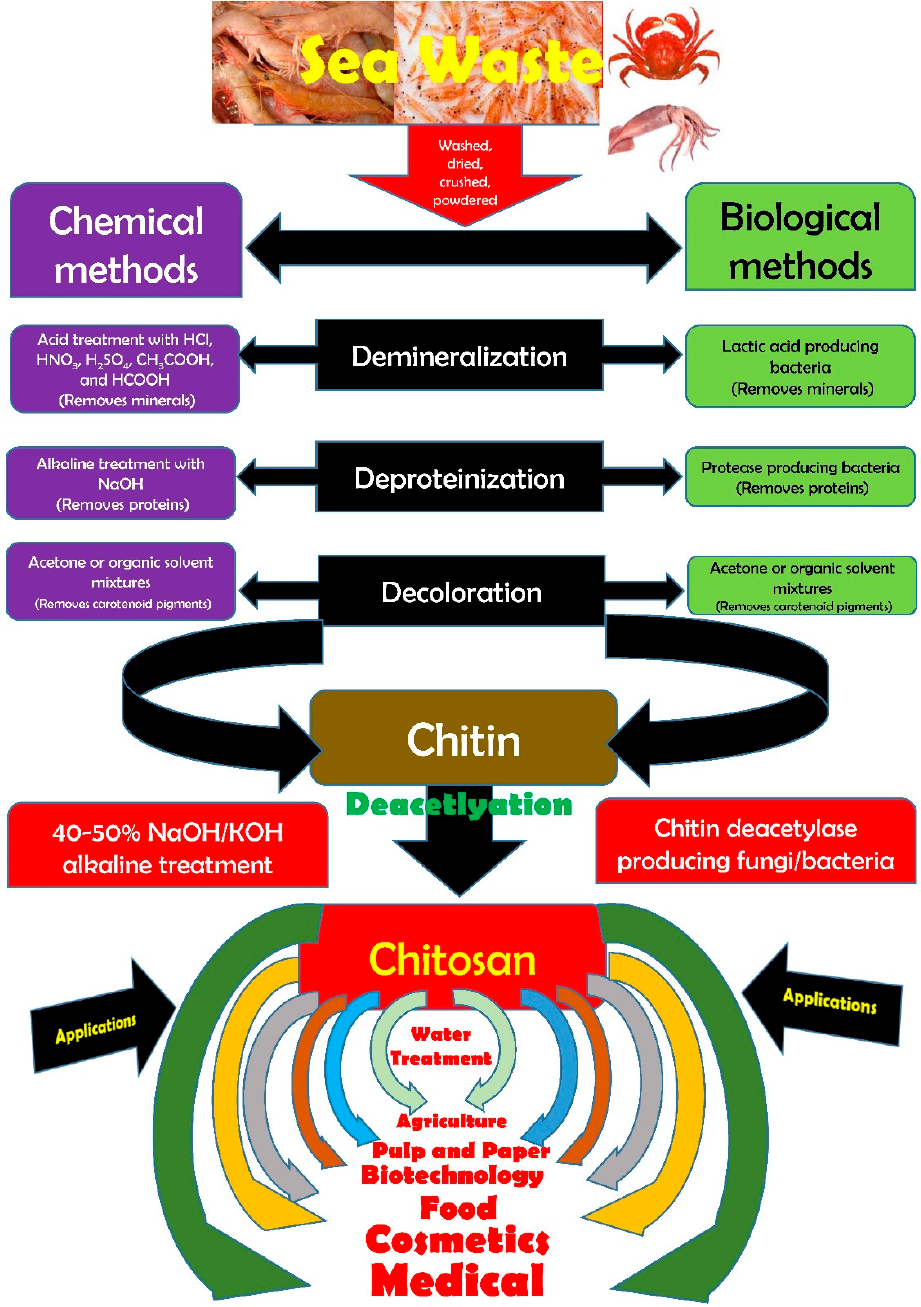
Figure 1. Overview of the recovery of chitosan from crustacean wastes.